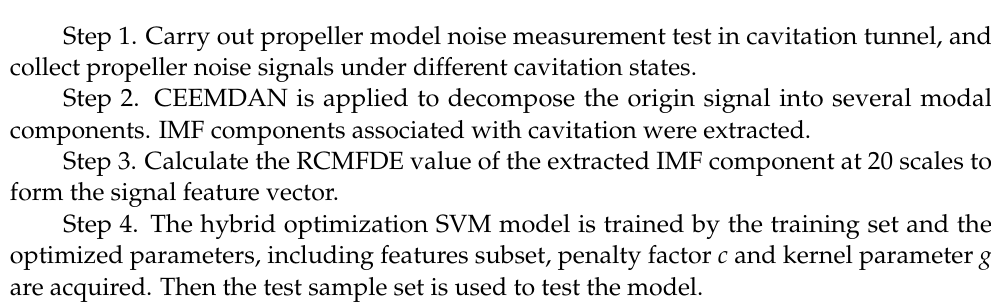
Figure 2. Flow chart of propeller cavitation state identification based on the proposed